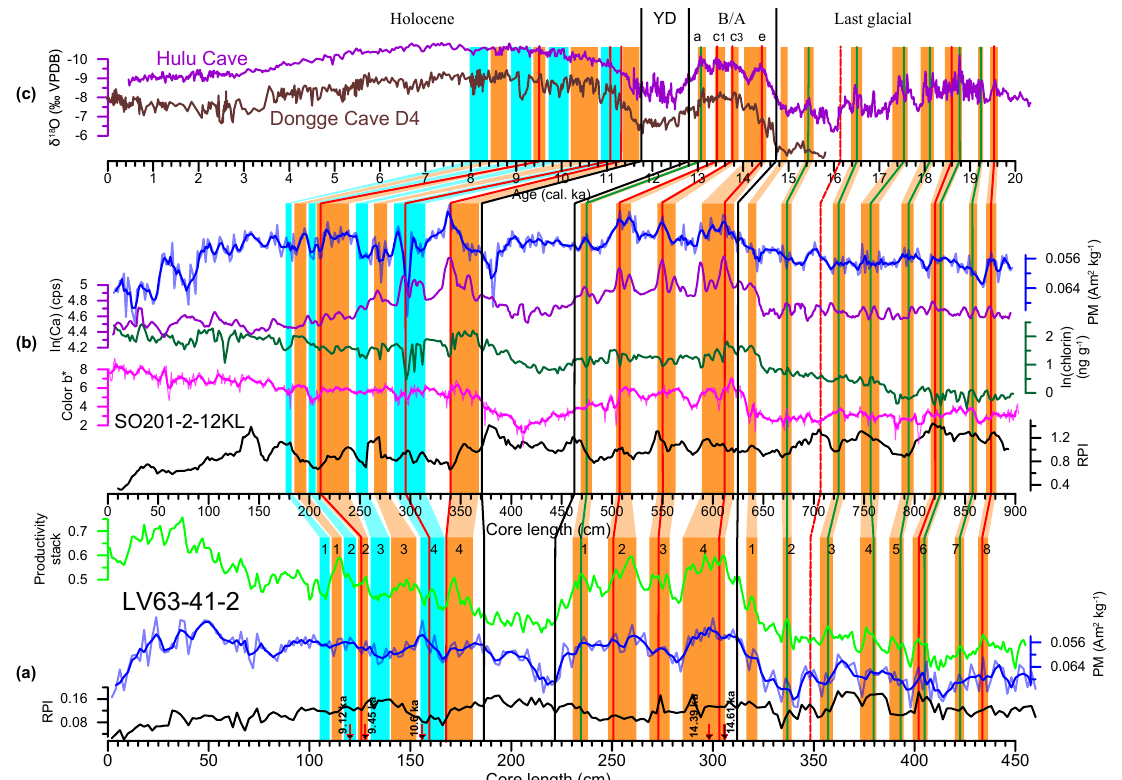
Figure 3. Age model of core 41-2. (a) RPI, PM and productivity stack of core 41-2 versus depth. (b) RPI, color b ∗ , chlorin, Ca and PM of core 12KL versus depth. (c) δ 18 O calcite of Chinese cave stalagmites (Dykoski et al., 2005; Wang et al., 2008) over the last 20kyr. The correlation of productivity events between core 41-2 and 12KL was established according to correlation of productivity stack of core 41-2 with productivity proxies of core 12KL and the RPI records of both cores. AMS 14 C data of core 12KL (red lines) were projected to the core 41-2 according to correlated productivity events. A close correlation of the productivity events with sub-interstadials in the EASM becomes apparent after projection of the radiocarbon data on the age scale of EASM. Green lines correlate EASM sub-interstadials with productivity events. Orange and blue bars are as in Fig.